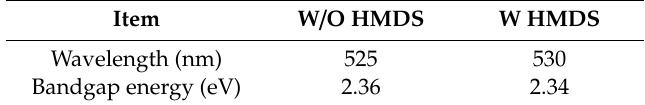
Table A1. Wavelength and bandgap energy of QDs without and with HMDS.